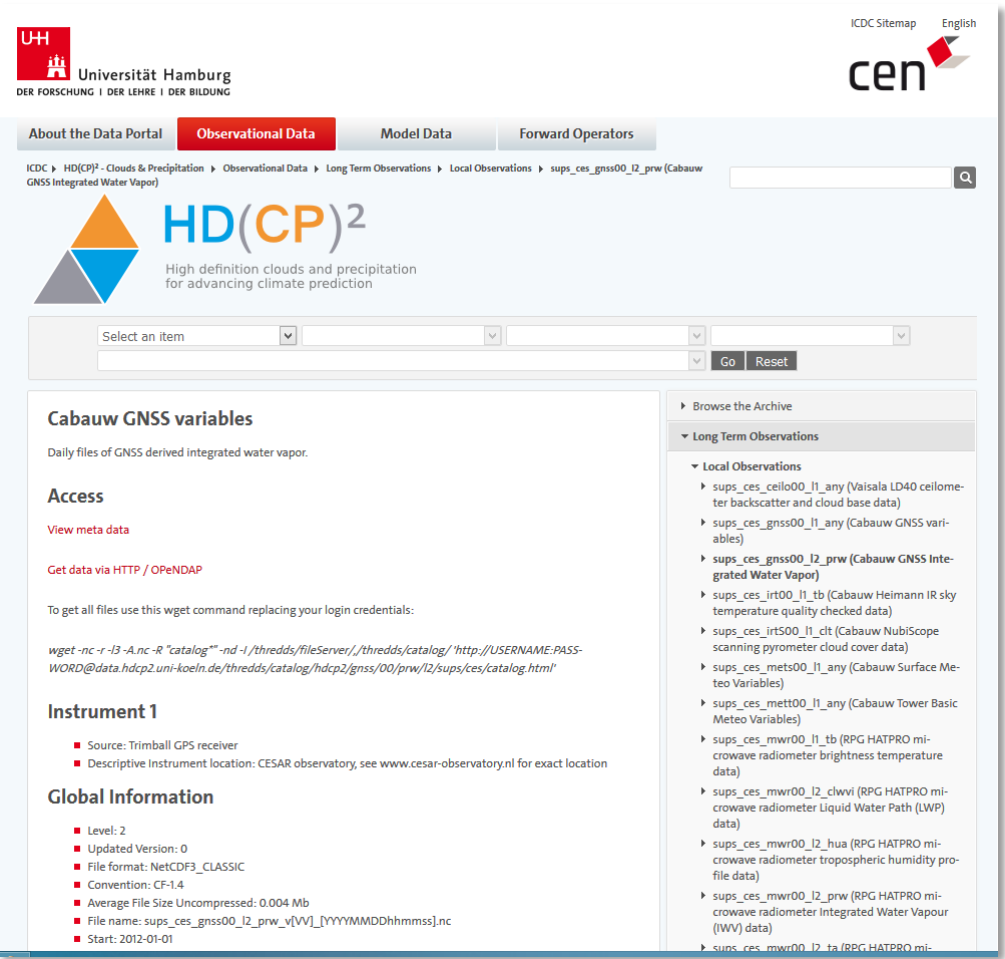
Figure 4. Example of a data sheet provided by the HD(CP) 2 web portal. The drop-down selection menu, based on the search tree (see Figure 5), appears directly below the project